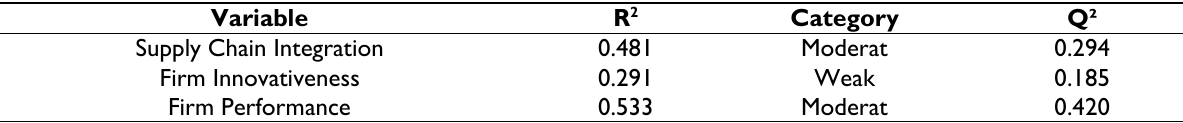
Table 4. Testing result of R 2 and Q 2